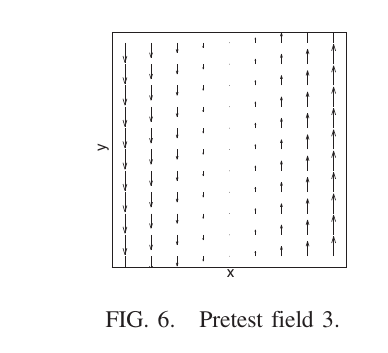
FIG. 6. Pretest field 3.